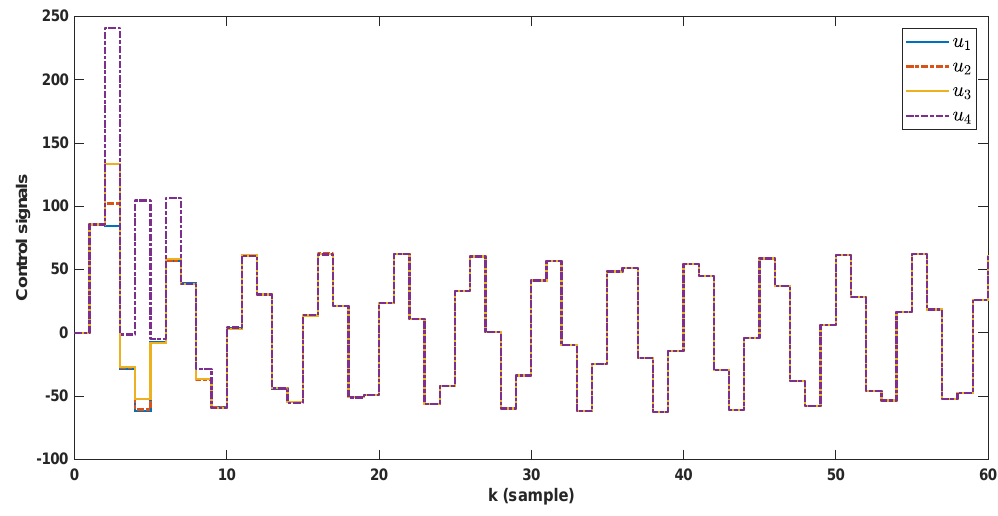
Figure 7. Example 1: Control signals.